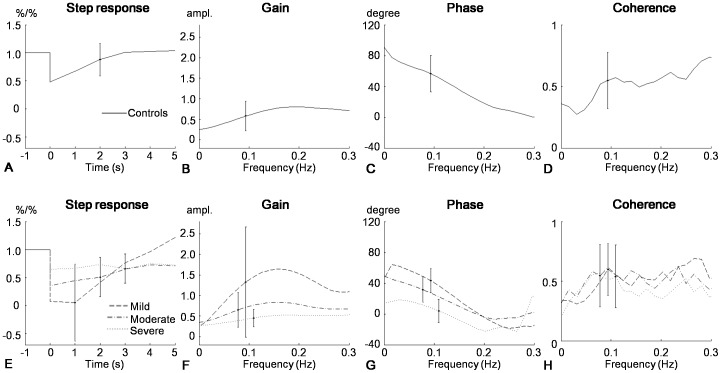
Time and frequency domain analysis of cerebral autoregulation using transfer function.The figures in rows are the averaged step response, gain, phase, and coherence function, respectively for the controls (A–D) and patients with middle cerebral artery stenosis (E–H), derived from the transfer function. As defined in (E), different line styles in the patients' row denote the stages, where mild, moderate, severe stenosis are the dashed, dashed-dotted, dotted, respectively. Each vertical bar shows the averaged standard deviation of the plotted parameter.